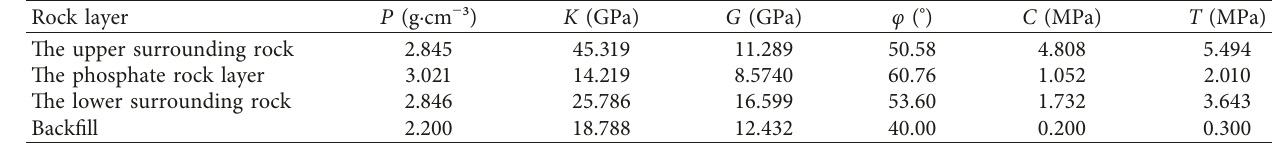
Table 1: Mechanical parameters of rock mass and the backfill.